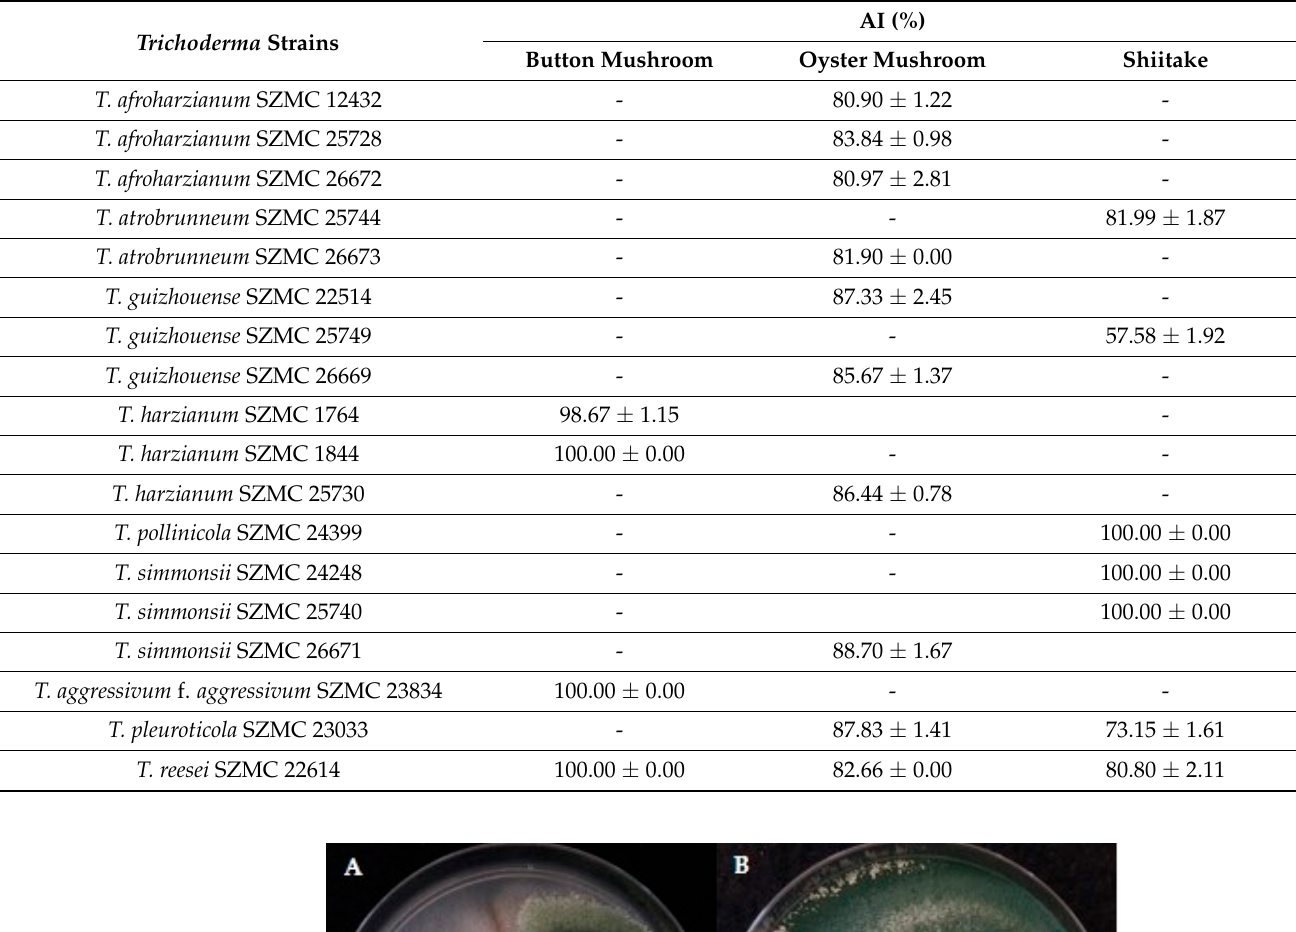
Table 3. Aggressivity index (AI) values of Trichoderma strains confronted with cultivated mushrooms (means of 2 replicates ± standard deviations).